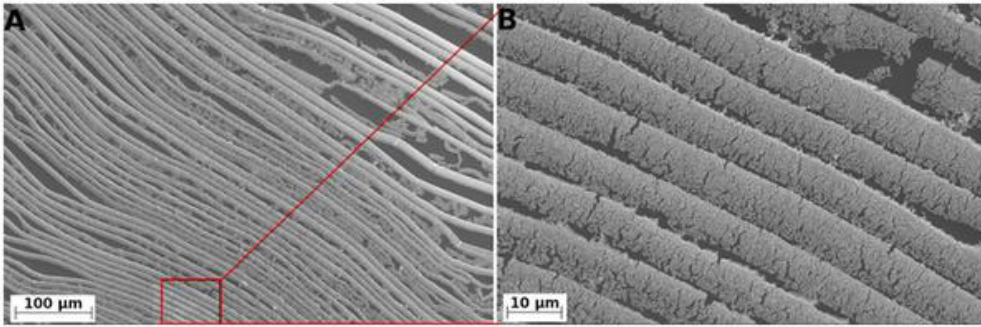
Figure 5. SEM images of gold nanobelts at low ( A ) and high ( B ) magnification. Reprinted with permission from [25]. Copyright 2012, PLOS